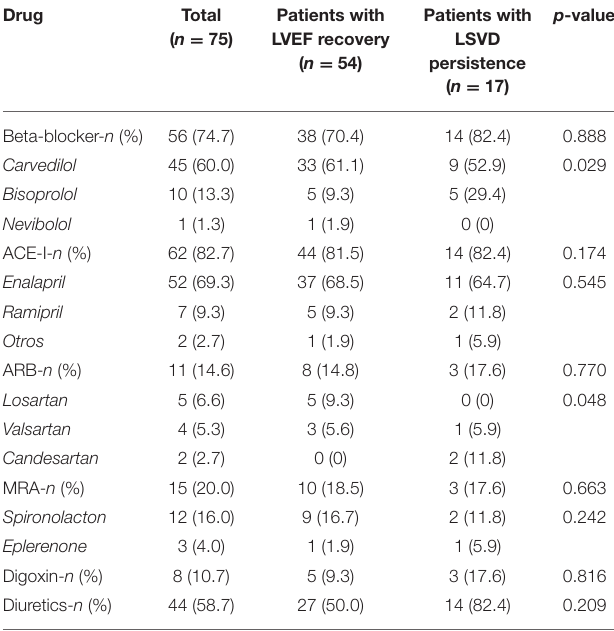
TABLE 3 | Treatment initiated in the patients with cancer therapy-related cardiomyopathy. Drug